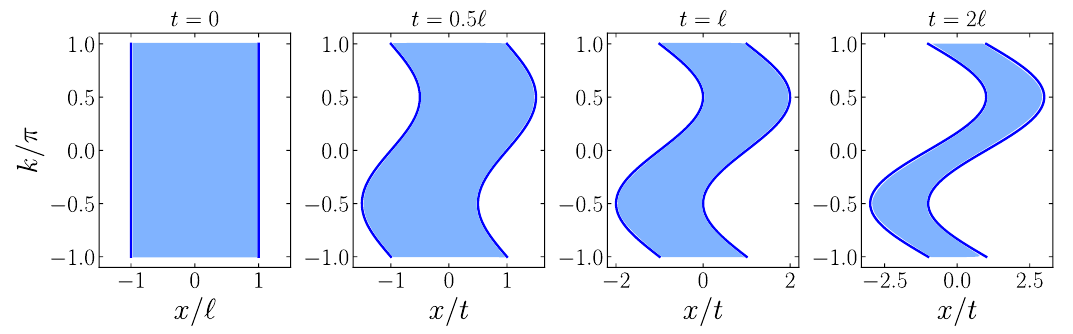
Figure 2: Snapshots of the Wigner function (12) during the melting dynamics of the double DW